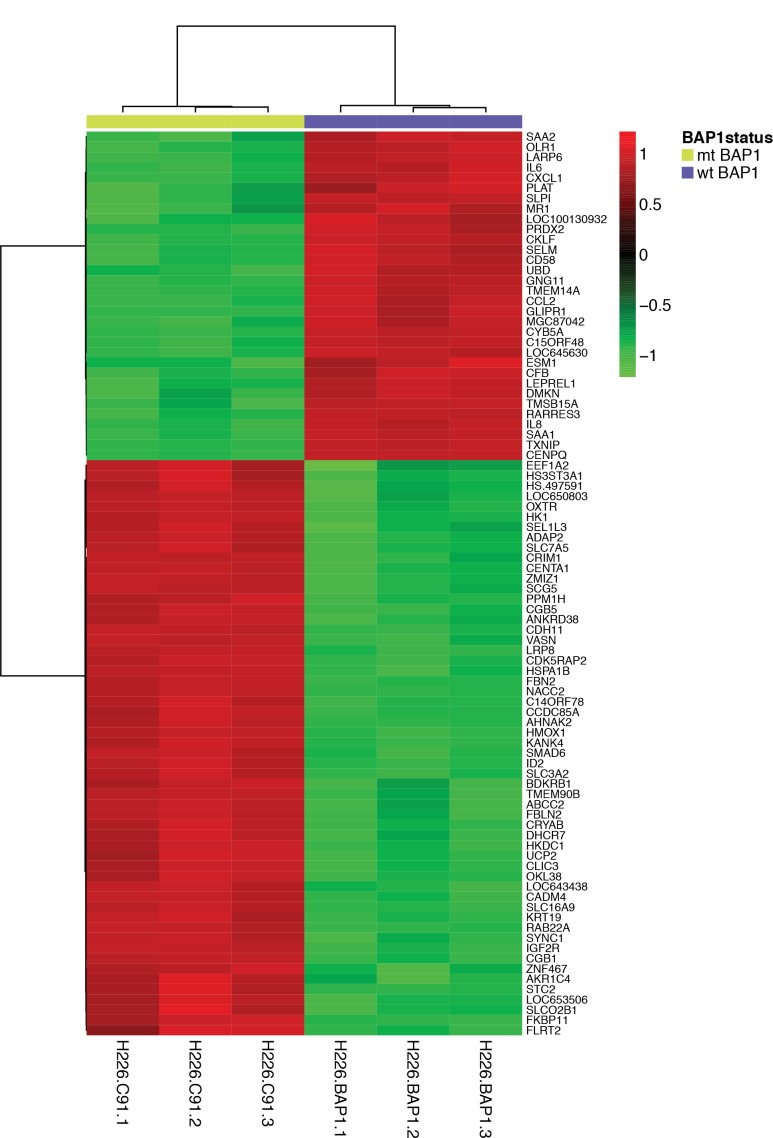
Differential gene expression data from H226 MM cells expressing C91A-mutant (mt BAP1) or wild-type BAP1 (wt BAP1).Only genes with logFC ≥2 and adj.p <0.05 are displayed.